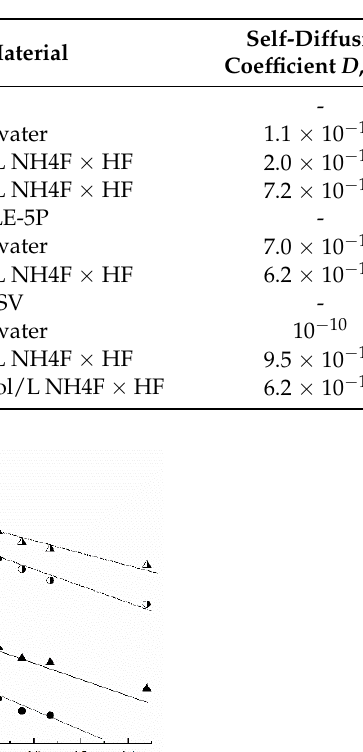
Table 12. Self-diffusion coefficients D at 293 K and self-diffusion activation energies E a of F − ions in the AV-17 resin and in the membranes ACLE-5P and ASV equilibrated with water or an aqueous solution of NH 4 F × HF.